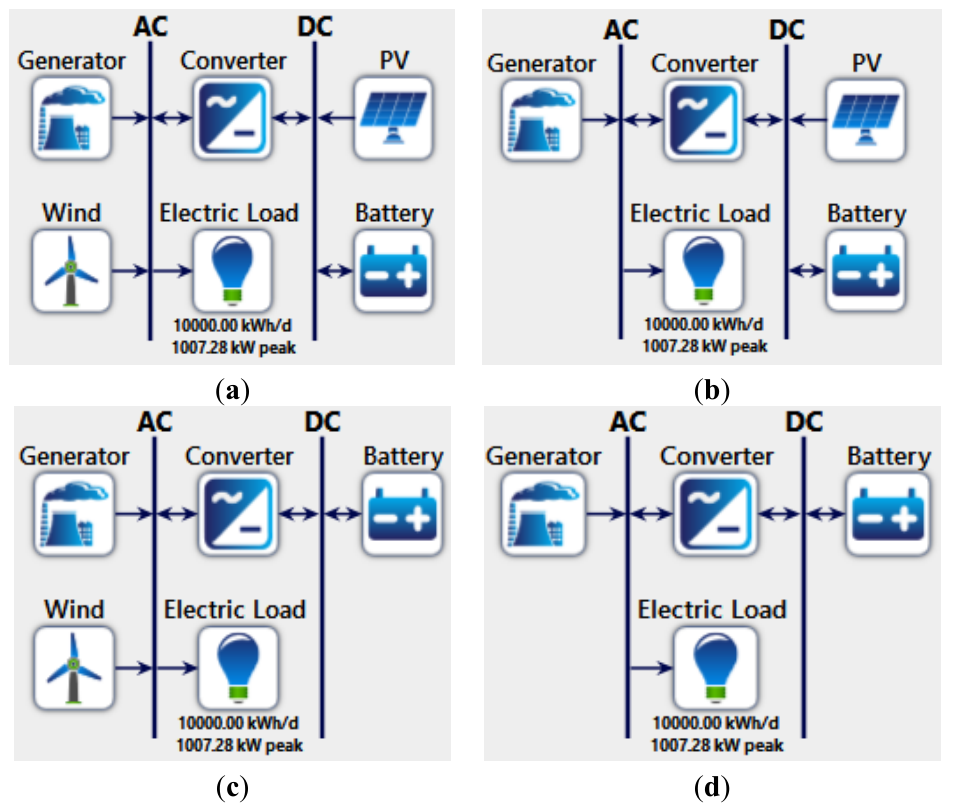
Figure 7. ( a ) Configuration of hybrid PV/wind/diesel/battery system; ( b ) Configuration of hybrid PV/diesel/battery system; ( c ) Configuration of hybrid wind/diesel/battery system; ( d ) Configuration of diesel/battery